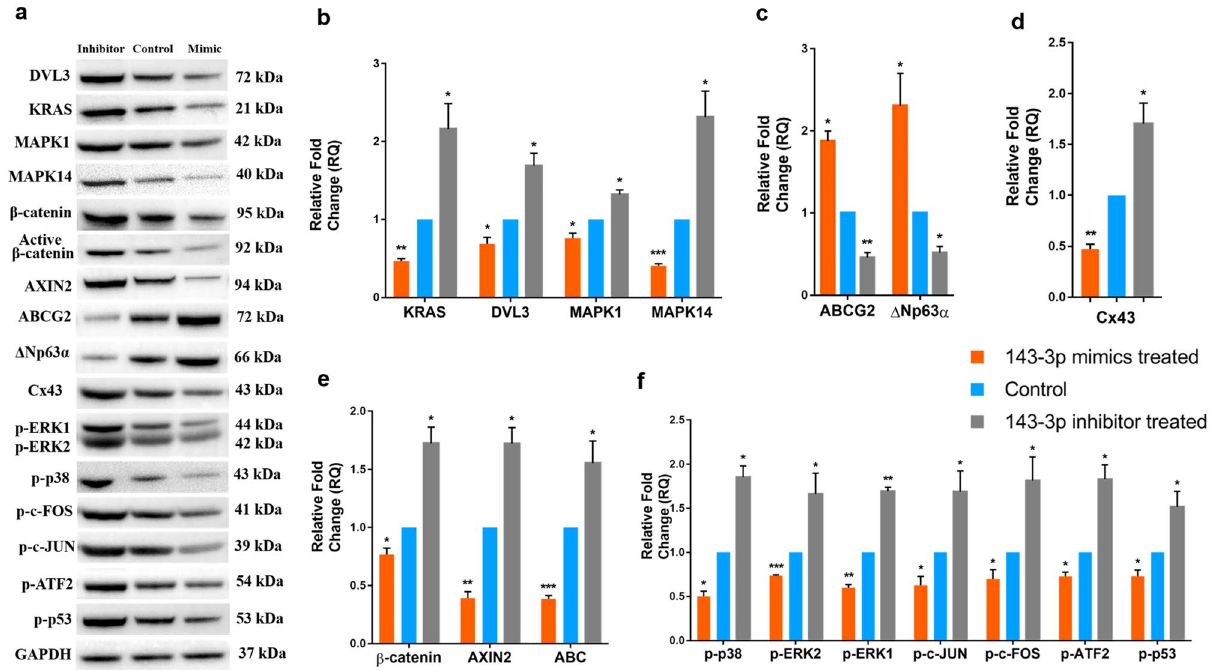
Figure 5. Protein expression profile of hsa-miR-143-3p transfected cells grown in 3D RAFT culture system. ( a ) Representative Western blots of protein of interest in three groups-hsa-miR-143-3p mimic, inhibitor and control transfected 3D RAFT cultured cells (n = 3): (i) hsa-miR-143-3p targets: DVL3, KRAS, MAPK1 and MAPK14, (ii) stem cell markers: ABCG2 and ΔNp63α (iii) differentiation marker, Cx43, (iv) Wnt signaling regulators: AXIN2, β-catenin and active β-catenin and (v) MAPK signaling regulators: p-ERK1/2, p-p38, p–c-JUN, p–c- FOS, p-ATF2 and p-p53. GAPDH was used as normalising reference and loading control. Bar graphs indicating the relative expression profile of the proteins quantified by Western blotting ( b ) hsa-miR-143-3p targets ( c ) Stem cell markers ( d ) Differentiation marker ( e ) Wnt signaling regulators ( f ) MAPK signaling regulators. * P < 0.05; ** P < 0.001; *** P < 0.0001. The relative protein expression values are provided in Table S5 and original Western blots images are provided in Fig. increased and expression of differentiation marker was decreased in the mimic transfected cells. Thus, these results collectively indicated the association of hsa-miR-143-3p in the maintenance of stemness in CESCs. Association of Wnt and MAPK signaling in the stem cell maintenance as well as differentiation has been reported. In limbal explant cultures, upon inhibition of Wnt signaling 28 and MAPK signaling 39,40 , the expression of stem cell markers (ABCG2 and p63α) and colony forming efficiency were increased. However, in the suspen- sion culture of isolated limbal epithelial cells Wnt signaling 41 and MAPK signaling 42 activation led to reduced colony forming efficiency and number of cells expressing high levels of p63α in cultured limbal colonies. The mimic transfected cells exhibited reduced expression of four predicted targets of hsa-miR-143-3p: KRAS, MAPK1 (ERK2), MAPK14 (p38α) and DVL3. Though the predicted targets were downregulated, the study has